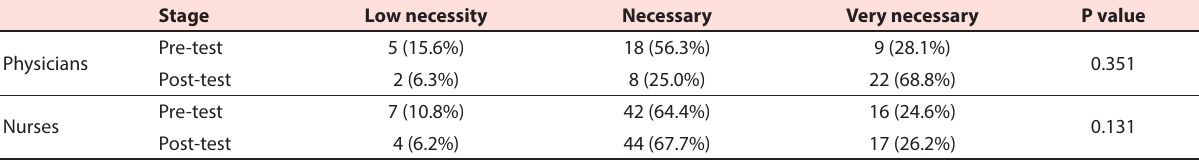
Table 3. Opinions of participants about necessity of opening a special ward for nuclear accidents victims in the hospital